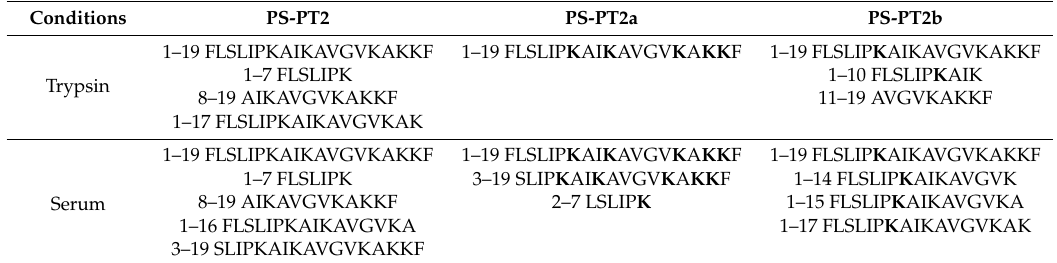
Table 3. Catabolites generated by incubation of PS-PT2 and its D -type analogues with trypsin or serum.